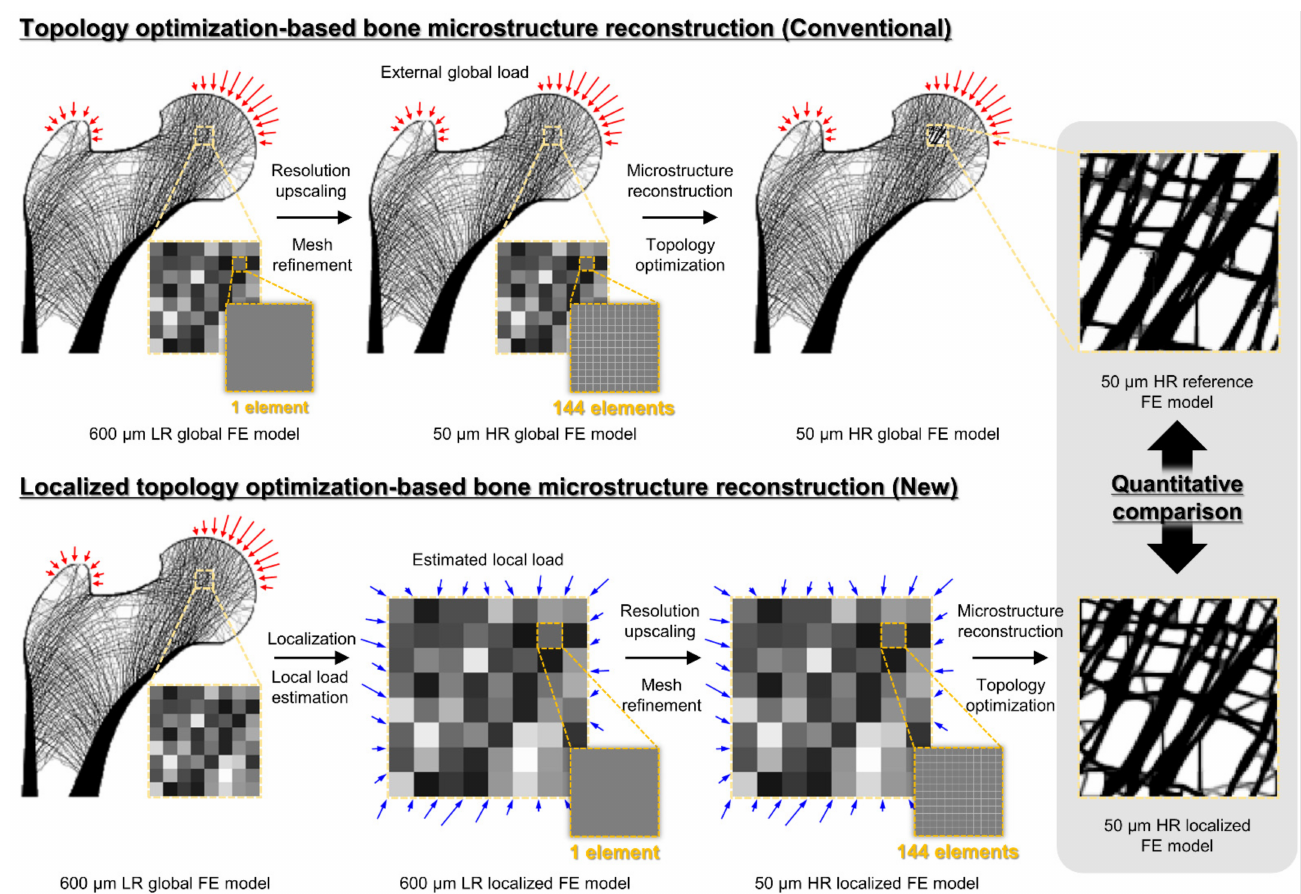
Figure 1. Overall validation procedure for the localized bone microstructure reconstruction method. The red arrows represent the external global load, and the blue arrows represent the estimated local